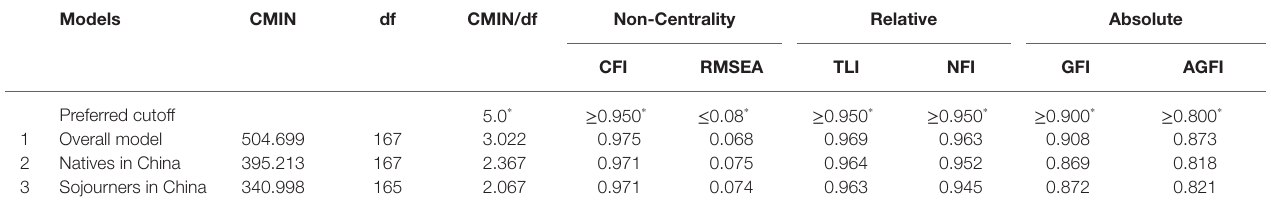
*Recommended limits by Hu and Bentler (1999).